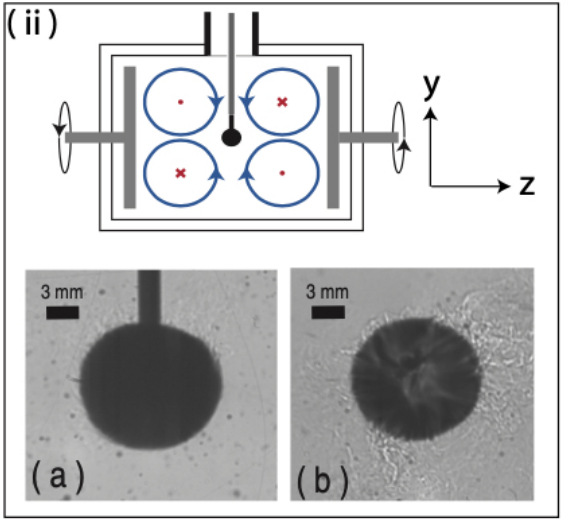
Figure 9. Figure 2 (ii) reproduced from [160], with permission from AIP Publishing (2013), showing the disk configuration of the experimental facility and image of the ice sphere when in fixed ( a ) and freely advected ( b )